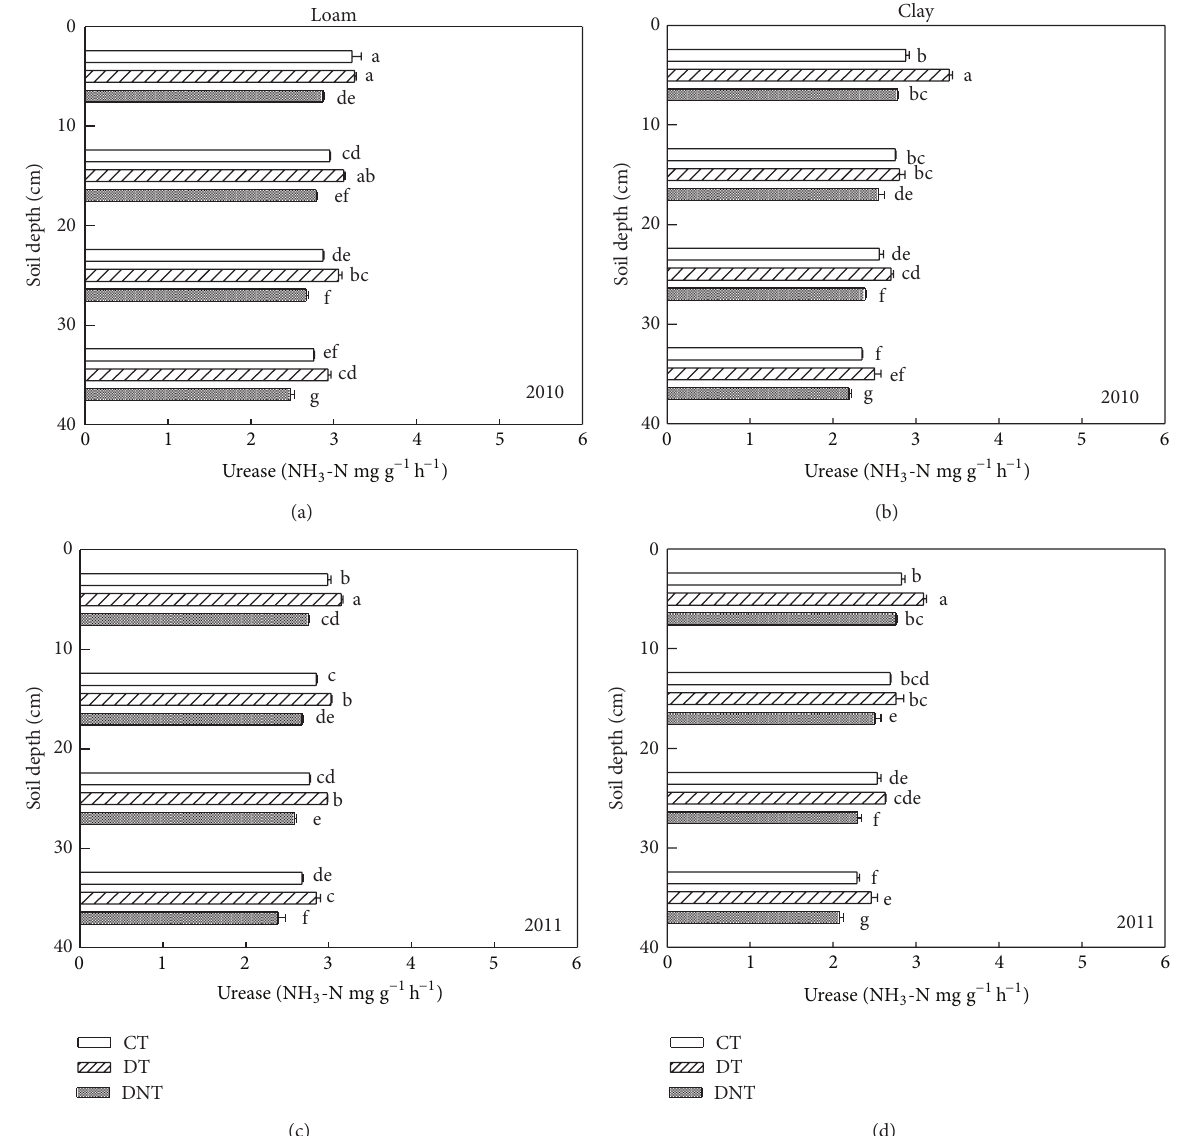
Figure 4: Effects of tillage and straw returning on soil urease activity. Different small letters indicated significant difference at 𝑃 < 0.05 according to Duncan’s test. CT represented conventional tillage, moldboard ploughed to a depth of 20 cm, and straw was returned. DT represented deep tillage moldboard ploughed to a depth of 30 cm and straw was returned. DNT represented deep tillage moldboard ploughed to a depth of 30 cm and straw was